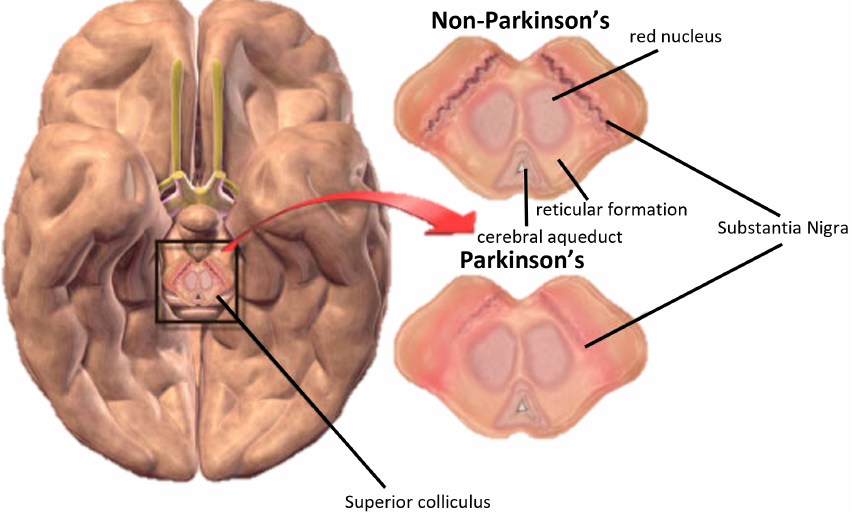
Figure 1. How Parkinson’s disease originates